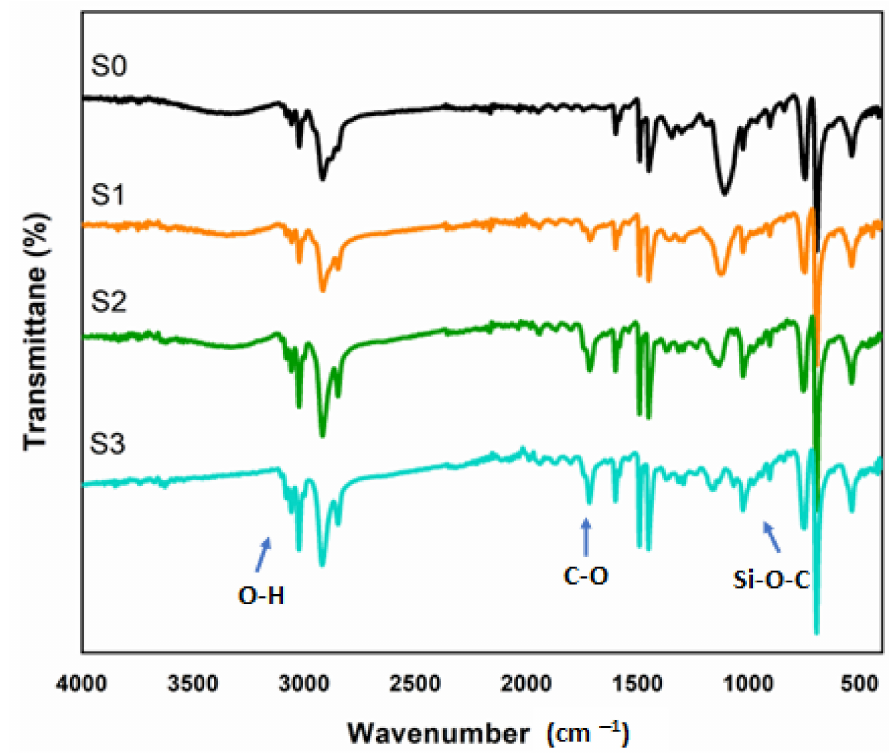
Figure 3. FTIR spectra of S0 (pristine PS), S1 (PS/1 wt.% m- sepiolite), S2 (PS/2 wt.% m-sepiolite) and S4 (PS/4 wt.%